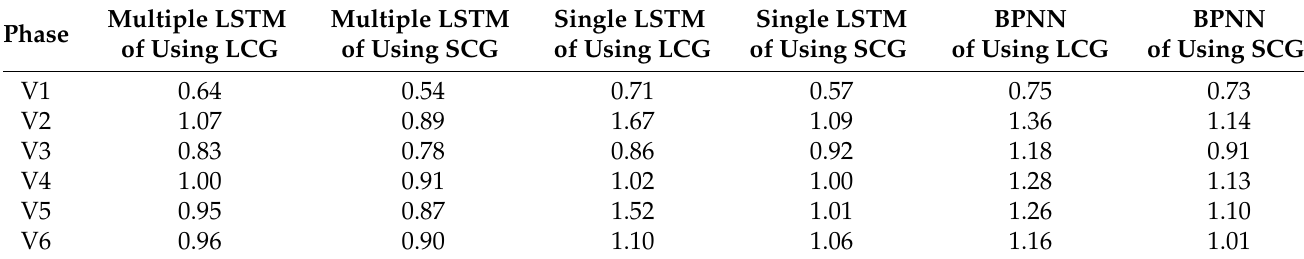
Table 2. The RMSE of throttle value for different operating materials and models.